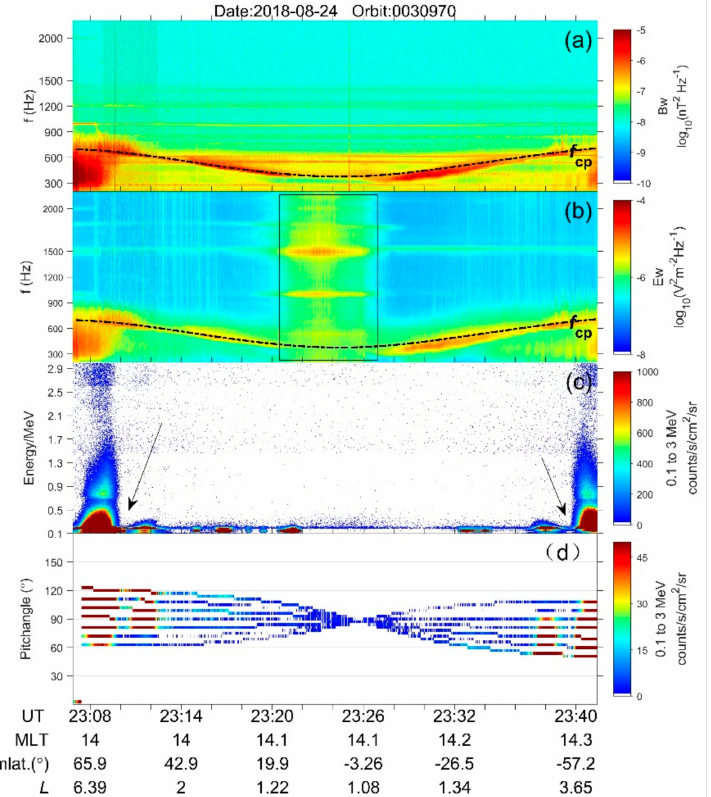
Figure 8. The ELF/VLF wave activities and energetic electron fluxes on the dayside ionosphere during magnetic quiet time recorded by No. 0030970 on 24 August 2018. From top to bottom: ( a , b ) power spectral density values of the magnetic and electric fields, ( c ) the energetic fluxes at energy band from 0.1 to 3.0 MeV, and ( d ) the energetic electron fluxes distributions along the pitch angles. Data are displayed as a function of universal time (UT), magnetic local time (MLT), geomagnetic latitude (mlat), and L shell,